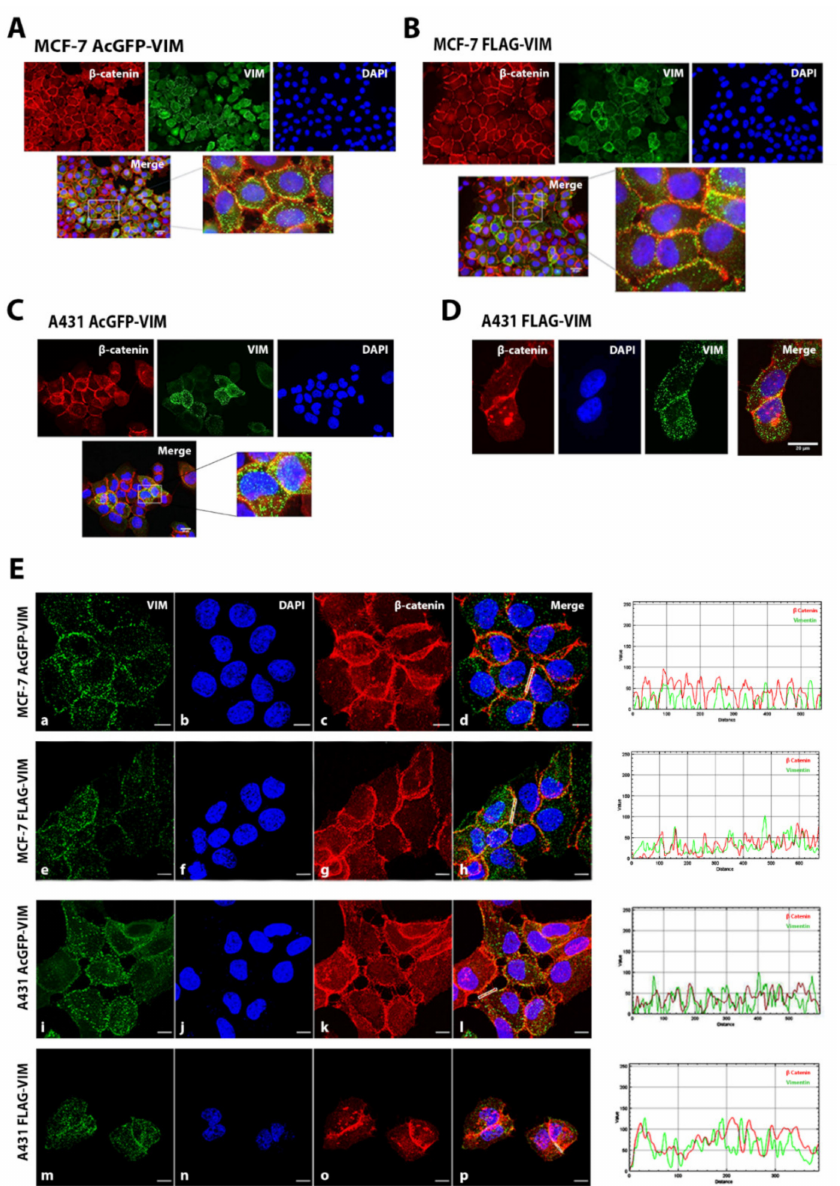
Figure 4. Co-alignment of vimentin globules with β -catenin in MCF-7 and A431 cells at intercellular junction. ( A , B ) MCF-7 and ( C , D ) A431 cells stably expressing ( A , C ) AcGFP-VIM and ( B , D ) FLAG- VIM were grown on collagen coated glass coverslips. The cells were immunostained with mouse anti- β catenin antibody and AF-594-labelled goat anti-mouse as secondary antibody (red). For cells expressing 3 × FLAG tagged vimentin, cells were stained with rabbit anti-FLAG antibody and AF-488 labelled goat anti-rabbit secondary antibody (green). Nuclei were stained with DAPI in blue and all overlapping images are shown as ‘Merge’. Leica DM4000B Epi-fluorescence microscope was used for visualisation and DFC350 camera was used for recording. Marked areas showing intercellular junctions were magnified for clarity in panels ( A – C ). ( E ) Images taken by Zeiss 880 laser scanning confocal microscope with Fast Airyscan and Multiphoton (inverted) system. Co-alignment between vimentin aggregates and β catenin is shown by line graph drawn using RGB profiler on maximal single confocal sections. The area used for this analysis is shown by a white line in different panels (scale bar = 20 µ